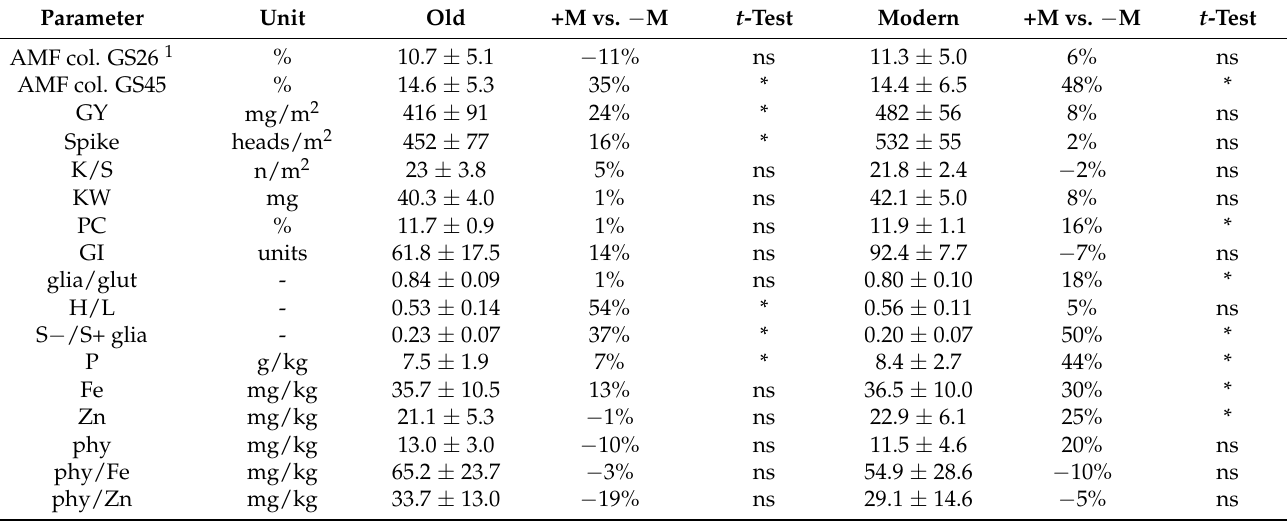
Table 4. Effect of AMF treatment on root colonization, agronomic and quality parameters in the old and modern groups of bread wheat genotypes. Data are expressed as mean values ( ± standard deviation) and percent change of the AMF inoculated samples in comparison with the untreated ones (+M vs. –M). Statistically significant differences were evaluated according to Student’s t -test at P <